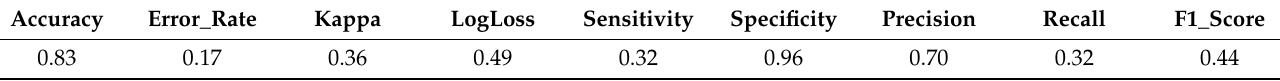
Table 2. Metrics evaluated for the KNN